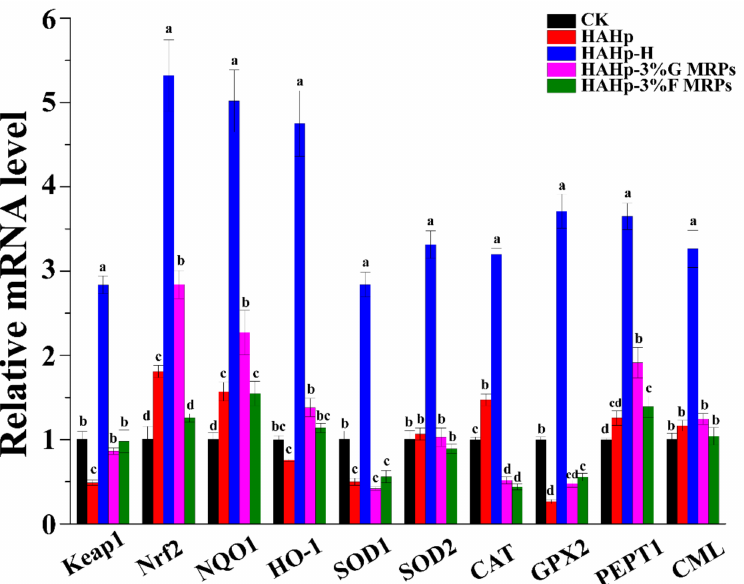
Figure 5. Effects of HAHp, HAHp-H, HAHp-3%G MRPs, and HAHp-3%F MRPs treatments on the related mRNA expression levels of Kelch-like ECH-associated protein 1 ( Keap1 ); transcription factors Nrf-2 ( Nrf2 ); genes associated protective phase-II enzymes NAD(P)H: quinine oxidoreductase- 1 ( NQO-1 ) and hemoxygenase-1 ( HO-1 ); genes of SOD1, SOD2, CAT , and GPX2 associated with the antioxidant enzymes; PEPT ; and CML in mice colon mucosa after 30 days oral administration. Different lowercase letters (a–d) in the same index represent significant difference ( p <